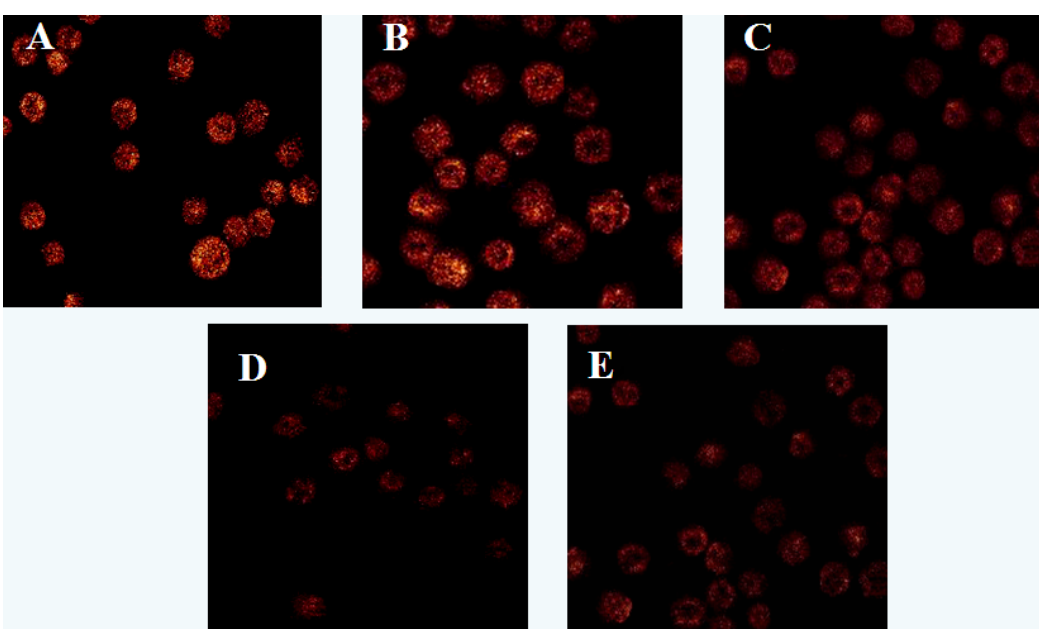
Figure 7. Effects of laminarin on intracellular fluorescent intensity of ΔΨ m in LOVO. ( A ) Cells were treated as control group; ( B ) Cells were treated with 400 µg · mL − 1 laminarin; ( C ) Cells were treated with 800 µg · mL − 1 laminarin; ( D ) Cells were treated with 1,600 µg · mL − 1 laminarin; ( E ) Cells were treated with 5 µg · mL − 1